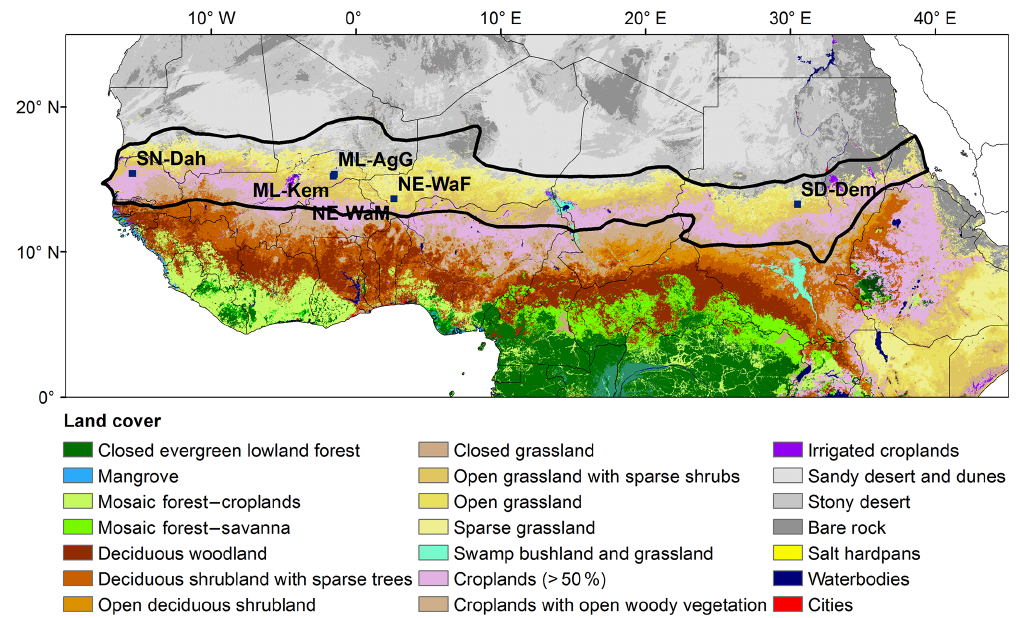
Figure 1. Land cover classes for the Sahel and the location of the six measurement sites of this study. The land cover classes are based on multi-sensor satellite observations (Mayaux et al., 2003). The sites are Agoufou (ML-AgG), Dahra (SN-Dah), Demokeya (SD-Dem), Kelma (ML-Kem), Wankama Fallow (NE-WaF) and Wankama Millet (NE-WaM). The thick black line delineates borders of the Sahel based on annual 150 and 700mm isohyets (Prince et al.,